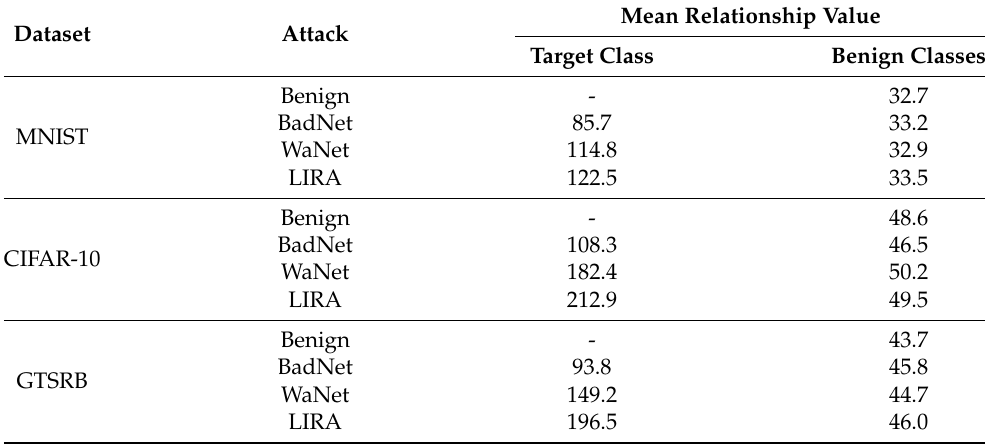
Table 1. The evaluation result of our multivariate-interaction-based interpretable backdoor-detection method. The mean relationship values are calculated for benign and poisoned models using Equation